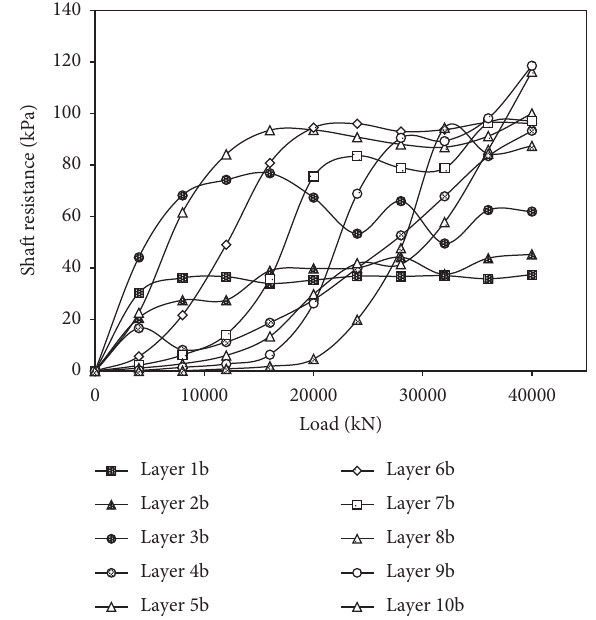
Figure 16: Shaft resistance development of P66.